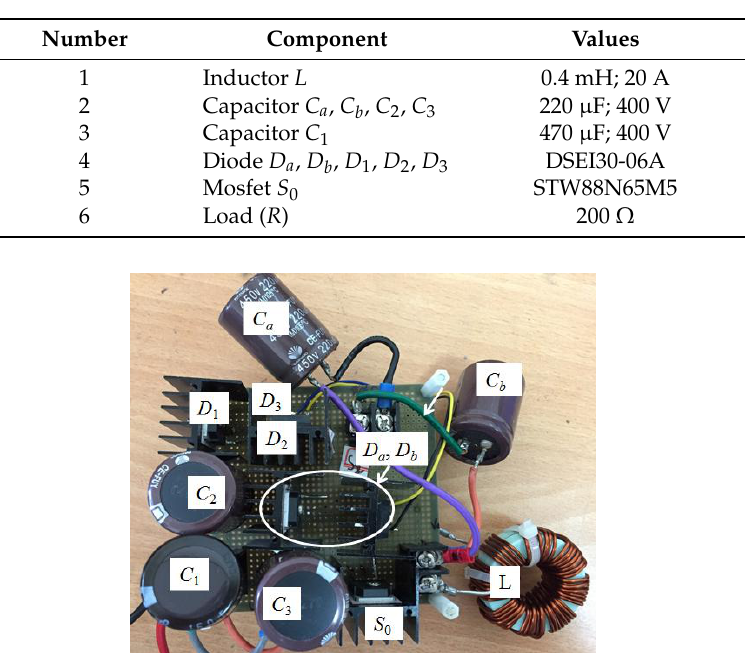
Table 6. Accessories used for experiments.